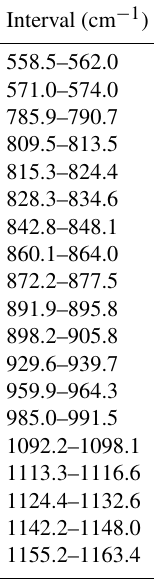
Table A1. Microwindows used in TCWret to retrieve the micro- physical aerosol or cloud parameters (Richter et al.,